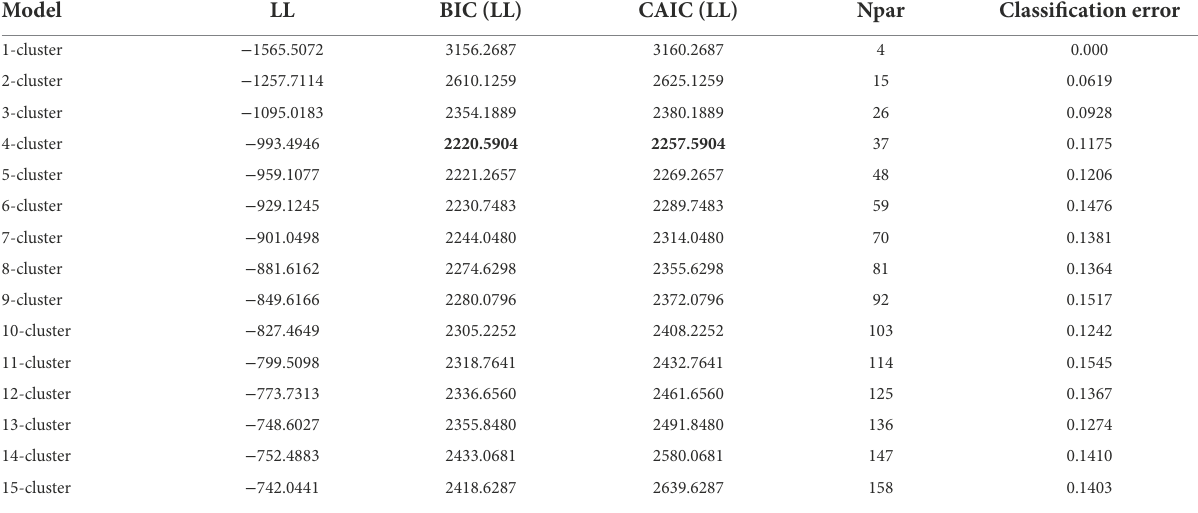
TABLE 2 Summary of latent profile cluster models.